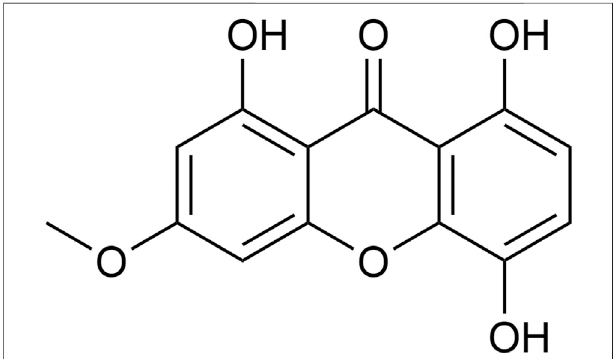
FIGURE 1 | Chemical structure of Bellidifolin